Question: In one sentence, what is this figure communicating?
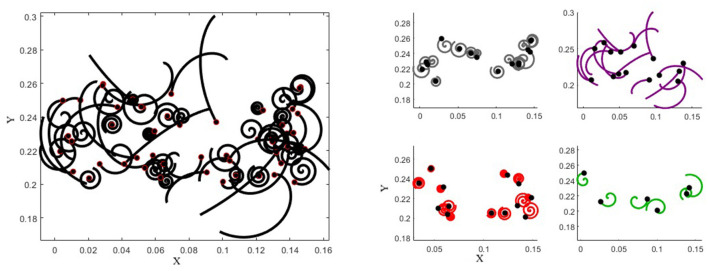
Answer: A family of curves with different curvature (left) and its clustering with respect to curvature (right) .